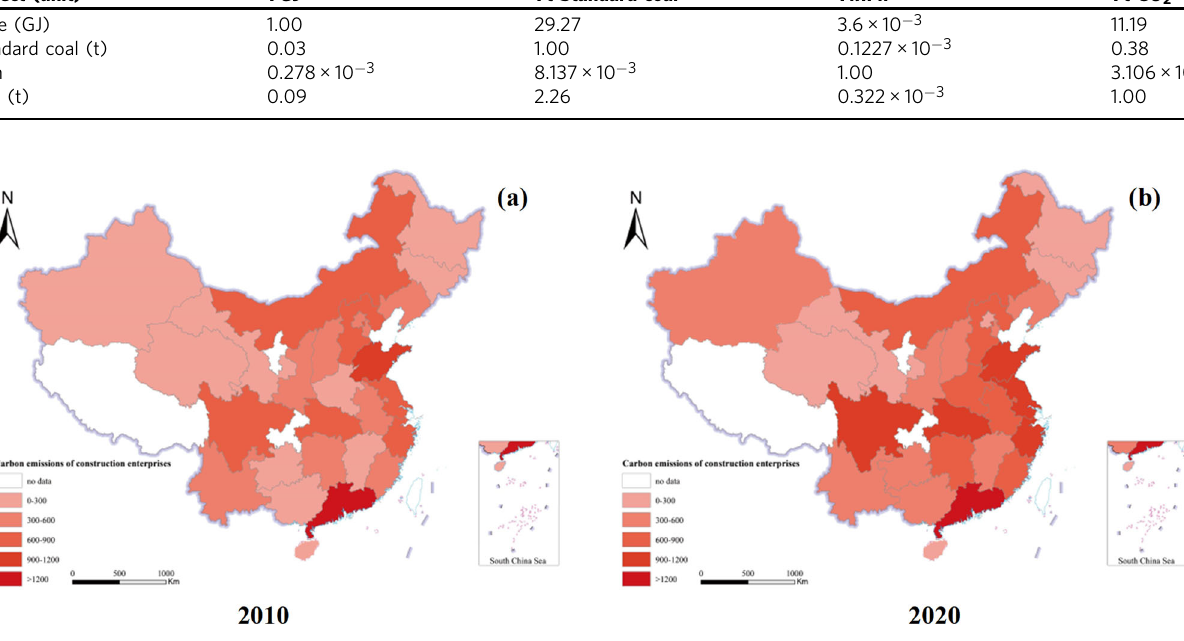
Fig. 3 Carbon emissions of China ’ s provincial administrative regions in 2010 and 2020. a Shows the carbon emissions of construction enterprises in China in 2010. b Shows the carbon emissions of China ’ s construction enterprises in